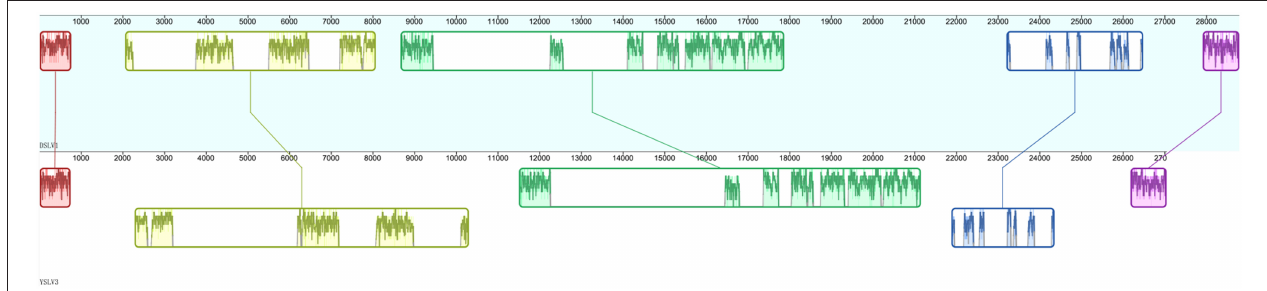
FIGURE 4 | Whole genome alignment of DSLV1 and YSLV3. Five conserved genomic regions, shared between DSLV1 and YSLV3, are displayed with rectangles of different sizes and